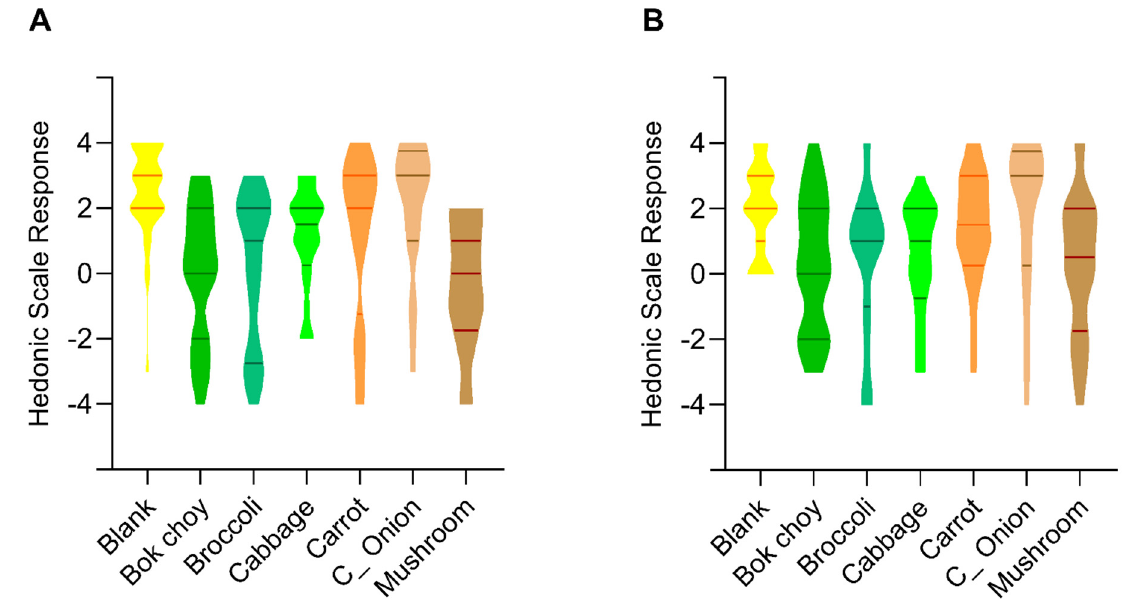
Figure 4. Pre-tasting sensory evaluation of differently fortified ugali . ( A ) violin plot of the sensory evaluation of color of differently fortified ugali ; ( B ) violin plot of the sensory evaluation of odor of differently fortified ugali . The x-axis title indicates the vegetable powder added in corresponding ugali , and lines in each violin plot are the upper quartile, median, and lower quartile line, respectively.